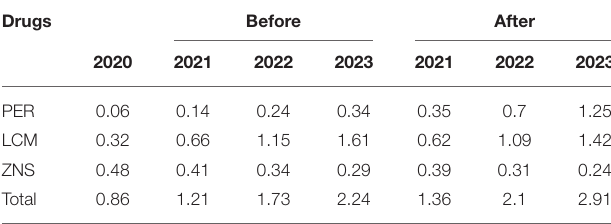
TABLE 4 | Market share (Before and after the inclusion of PER in the NRDL), %. Drugs